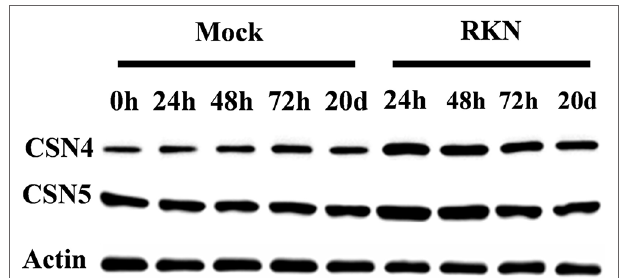
FIGURE 2 | The changes of CSN4 and CSN5 proteins in wild-type tomato plants at different time points after root-knot nematode (RKN) infection. Equal protein loading was confirmed using an anti-actin antibody. The labels 0 h, 24 h, 48 h, 72 h, and 20 d (h, hour; d, day) indicate the time after RKN infection. Three independent experiments were performed with similar